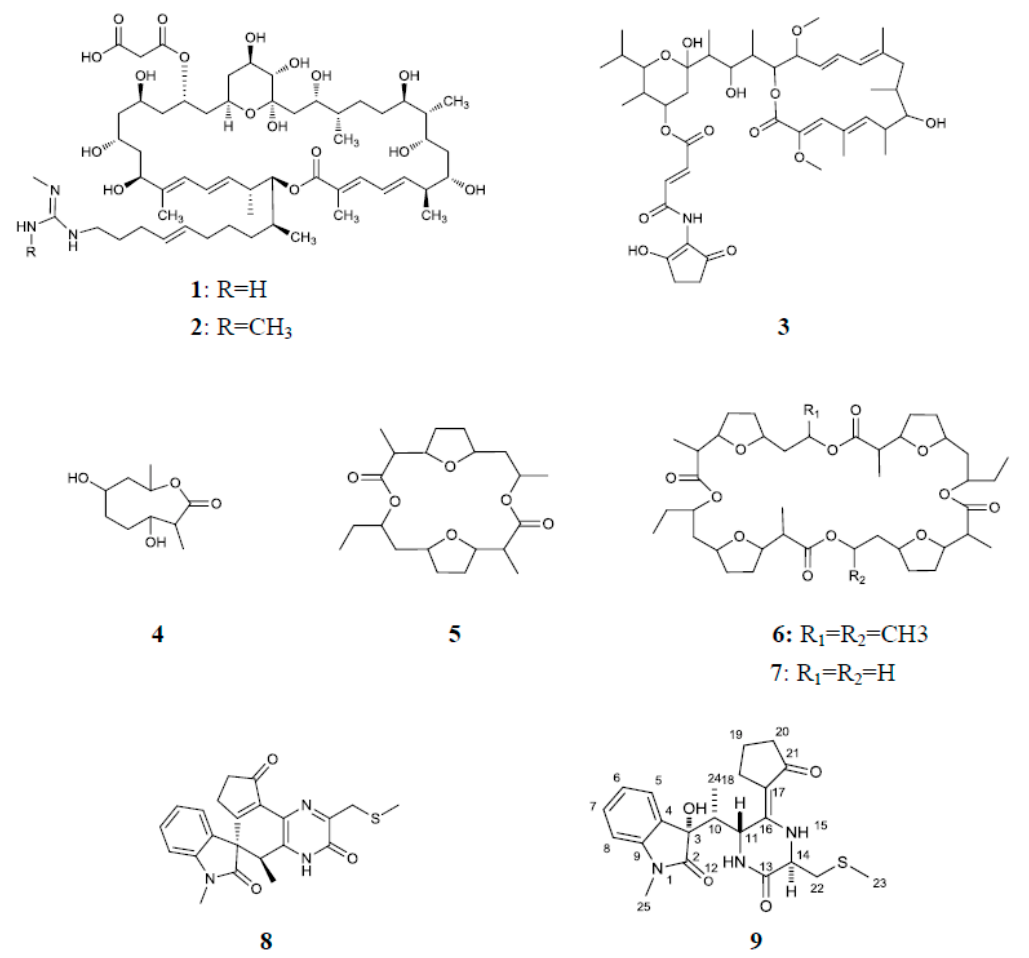
Figure 3. The structures of compounds 1 – 9 .